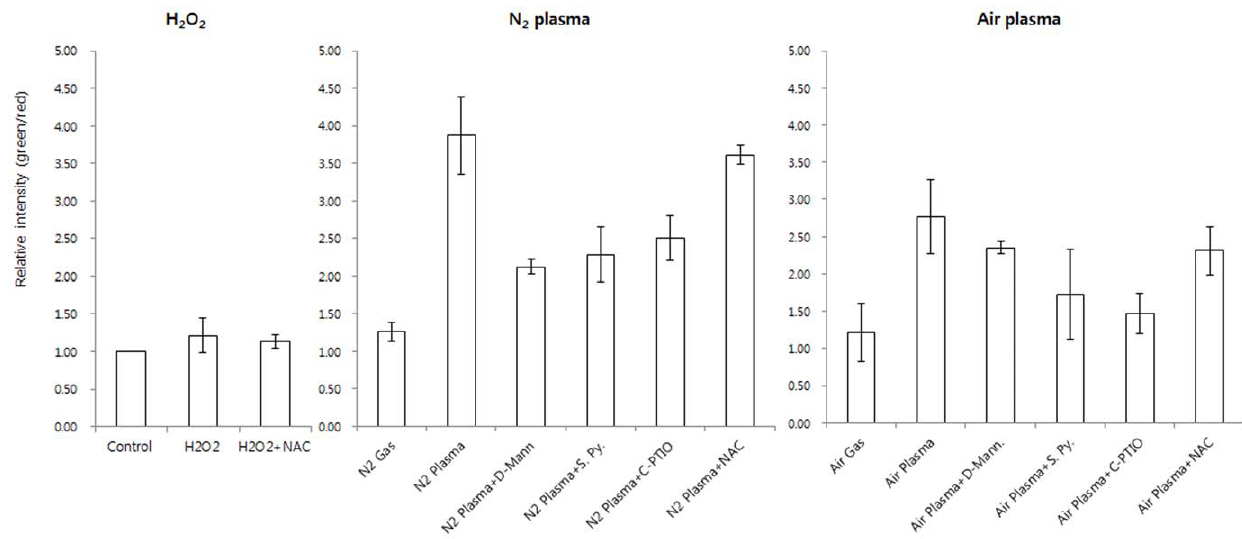
Figure 4. Mitochondrial transmembrane potential (MMP) was measured by flow cytometry, following staining with JC-1 dye. Cells were treated with ROS scavenging agents, D -Mannitol, sodium pyruvate, carboxyl-PTIO or N-Acetyl-cystein (NAC) for 1 hr prior to treatment with a plasma jet. After N 2 or air plasma jet treatment, cells were incubated for a further 12 hr before harvesting. After harvest, the cells were washed 3 times with PBS and stained with 2.5 m M JC-1 dye for 30 min. Green fluorescence monitoring depolarization of mitochondrial membrane potential ( Dy m) of the untreated cells was arbitrarily set to a value of 1. Data are shown as the mean 6 s.e.m. ( n =7).